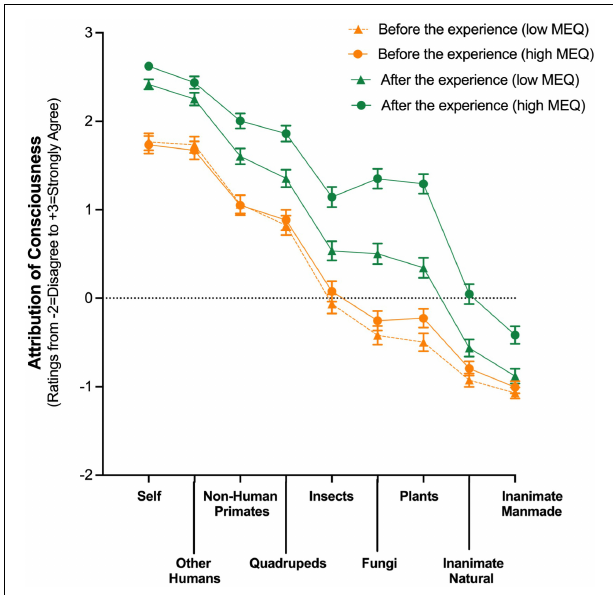
FIGURE 2 | Attribution of consciousness to living and non-living entities after a psychedelic belief-changing experience is greater in those with higher scores on the Mystical Experience Questionnaire (MEQ). Y axis: Rating of agreement with the belief that the entity has capacity for conscious awareness from Disagree (–2) to Strongly agree (+3), with Neither agree nor disagree (0) indicated by dotted line. X axes: categories of living and non-living entities. Data are means ( ± 1 SD); yellow symbols indicate ratings before the experience; green symbols indicate after the experience; triangles and circles indicate the low and high MEQ groups, respectively, with the low group consisting of scores below the median MEQ score. In both the low and high MEQ groups all differences from “Before” to “After” the experience met statistical and effect size criteria for being meaningfully different. Furthermore, with the exception of “Other Humans,” all differences between the low and high MEQ groups met these criteria for being meaningfully different at the “After” timepoint (i.e., the comparison between green triangles and green circles) ( Supplementary Material ).